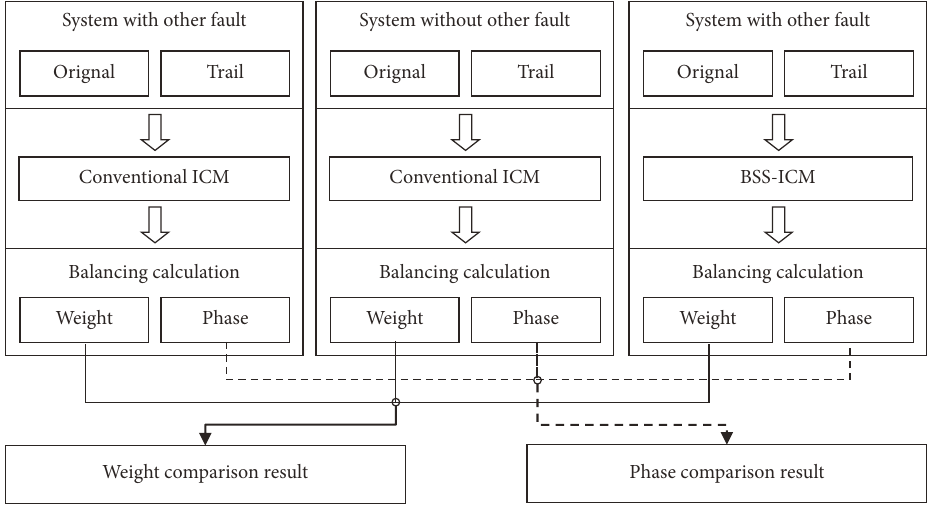
Figure 3: The main comparison flowchart using the proposed method. Table 1: Same parameters used for simulation and experiment cases.